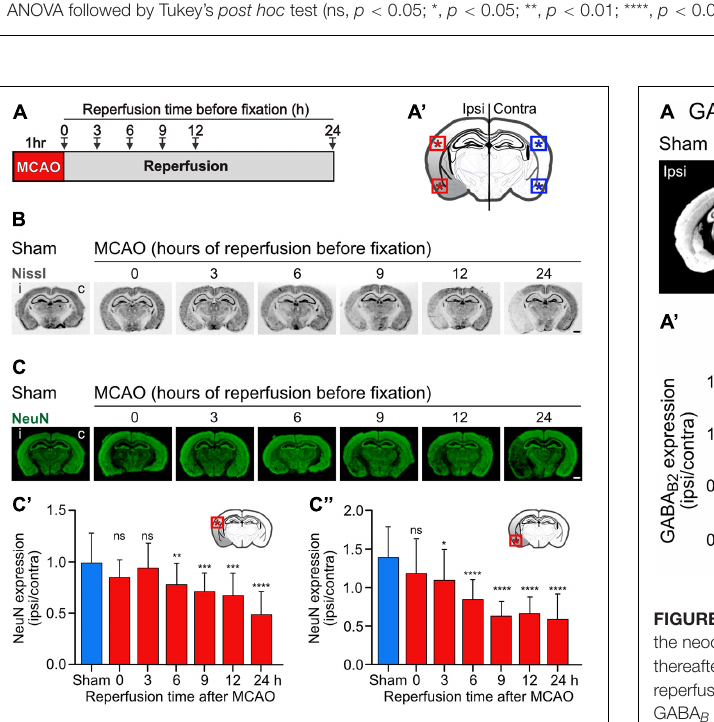
FIGURE 3 | Progressing neuronal loss in the cerebral cortex in the mouse MCAO model of ischemic stroke. Mice were subjected to Sham or MCAO surgery followed by 0, 3, 6, 9, 12, and 24 h reperfusion. Brains were then fixated and analyzed for neuronal loss in the cerebral cortex using Nissl (B) and NeuN (C) staining. (A) Scheme of the experimental design. (A (cid:48) ) Schematic drawing of a coronal mouse brain section indicating the areas analyzed in this study (dorsal and ventral cortex). (B) Representative images of Nissl stained brain sections obtained from Sham and MCAO treated mice reperfused for the indicated time intervals before fixation (scale bar, 1 mm). (C) Representative images of NeuN stained brain sections (scale bar, 1 mm).